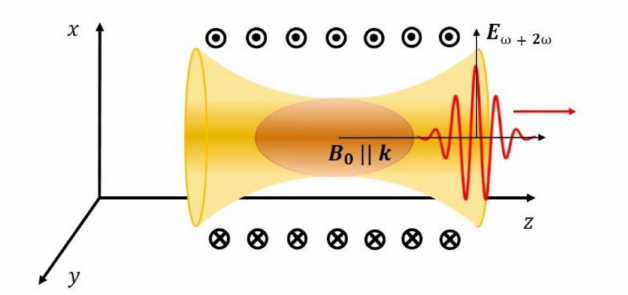
Figure 1. Principal scheme of plasma formation by two-color laser pulse. Static magnetic field is assumed to be along the plasma volume formed by the ionizing femtosecond two-color